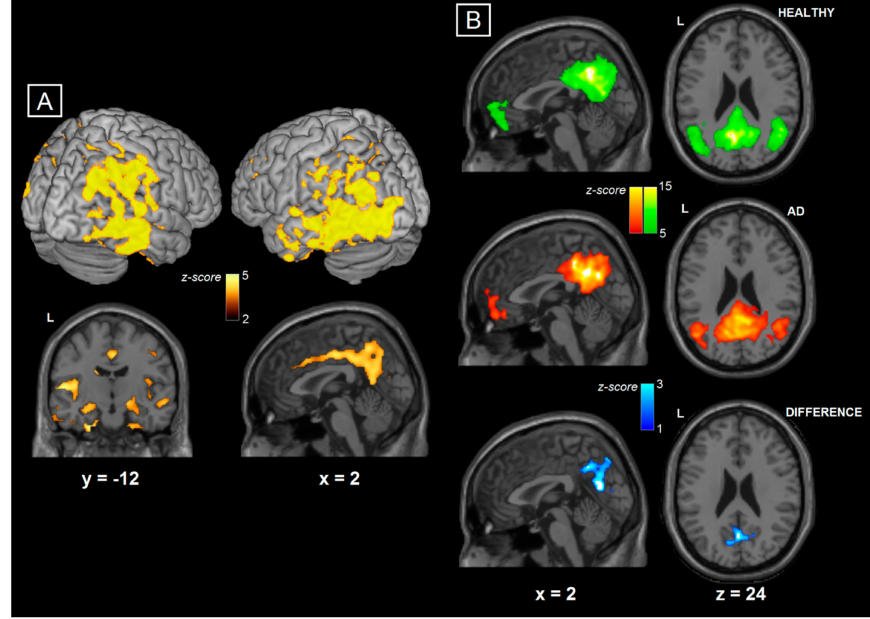
Figure 2. ( A ) Structural MRI, group comparison between AD and HC; Structural MRI comparison between the two diagnostic groups showing the regions where HC had larger grey-matter volumes than AD patients. Results show clusters surviving a Family-Wise-Error corrected cluster-level p < 0.05. Montreal Neurological Institute coordinates are indicated at the bottom of each slice. ( B ) Functional MRI, group comparison between AD and HC. fMRI comparison between AD and HC groups showing the regions where HC had more DMN fMRI connectivity than AD patients. Differences were visible in a cluster surviving a Family-Wise Error corrected cluster-level p < 0.05 extending to the posterior cingulate gyrus and precuneus (peaks in Brodmann Areas 7, 29 and 31). Montreal Neurological Institute coordinates are indicated in the figure. This finding is consistent with previous publications and shows loss of connectivity in the posterior part of the